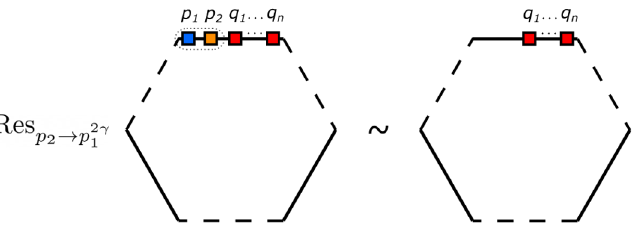
Figure 4 . The decoupling condition. When the particles in the form factor feature a particle- antiparticle pair (here, those with momenta p and p , the latter in the crossed channel), those 1 2 decouple: the form factor diverges as a simple pole whose residue is the form factor of the remaining particles ( q in the 1 , . . . , q n